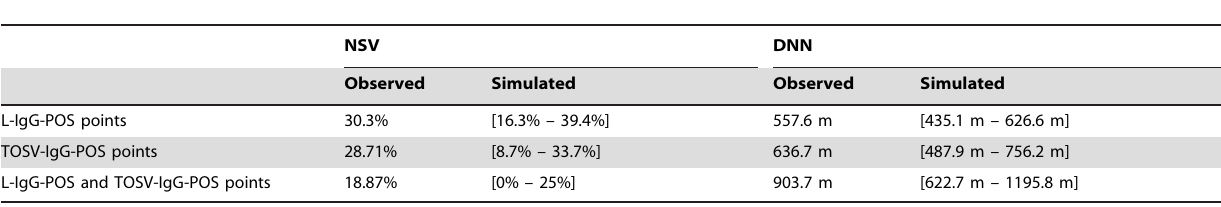
Table 2. Results of analysis of the spatial clustering of positive